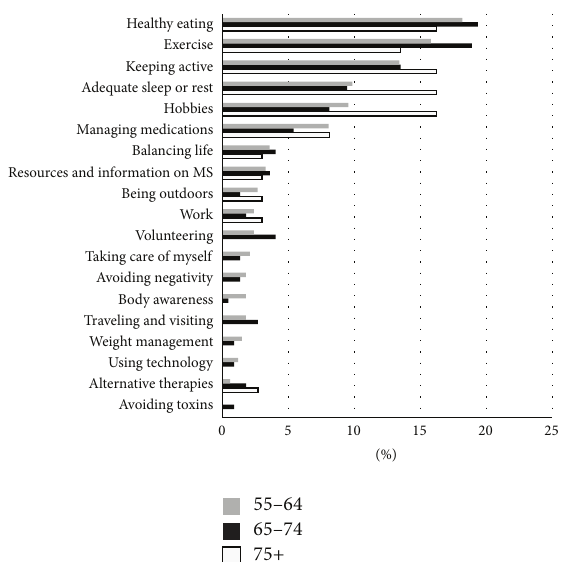
Figure 3: Age stratification of healthy lifestyle choices and habits. The figure displays the relative importance of each subtheme by age category. Those aged 75 and older identified just over half as many subthemes as the younger age